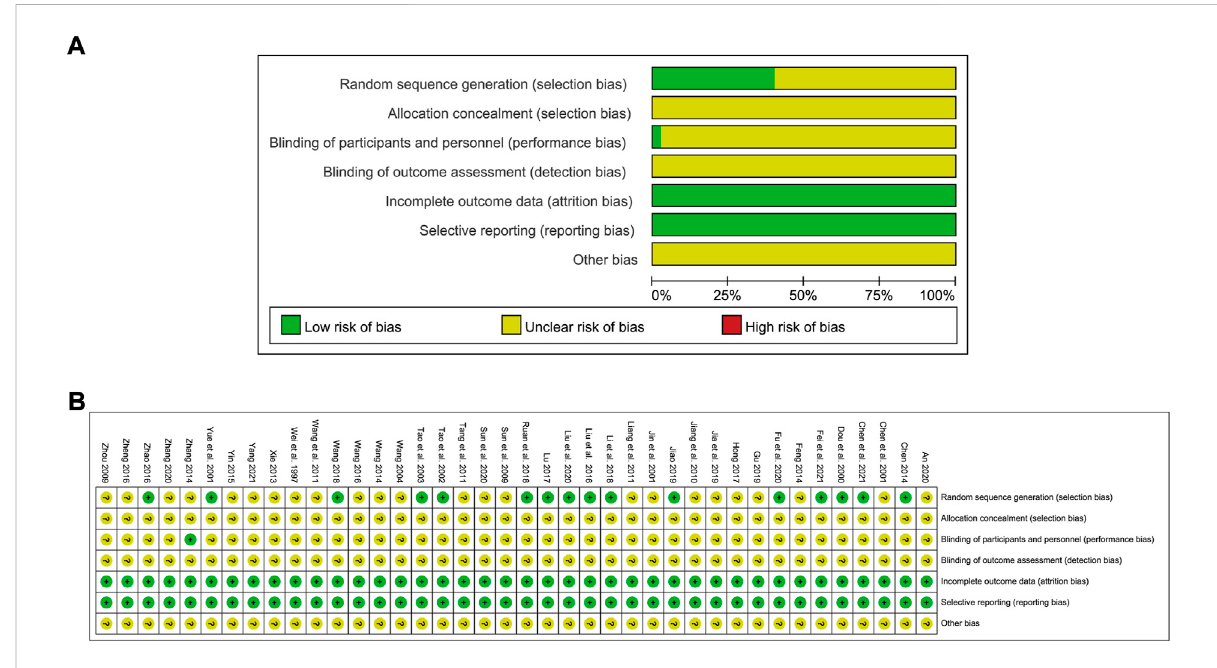
FIGURE 2 Risk of bias graph showing the quality of included studies. (A) Risk of bias graph; (B) Risk of bias